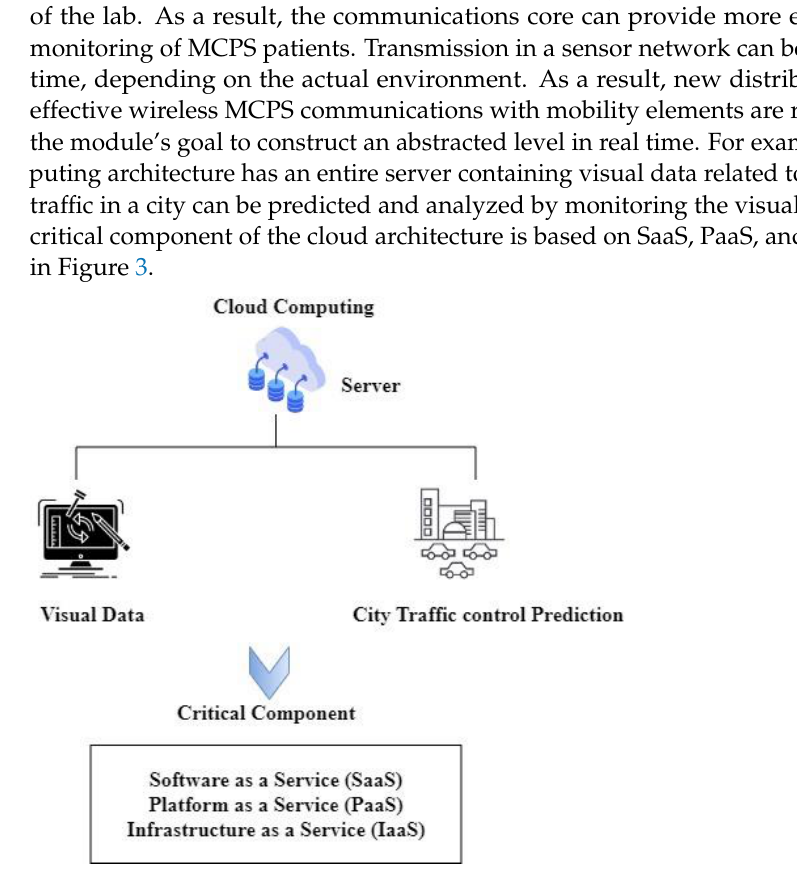
Figure 3. Critical components of the cloud computing architecture.